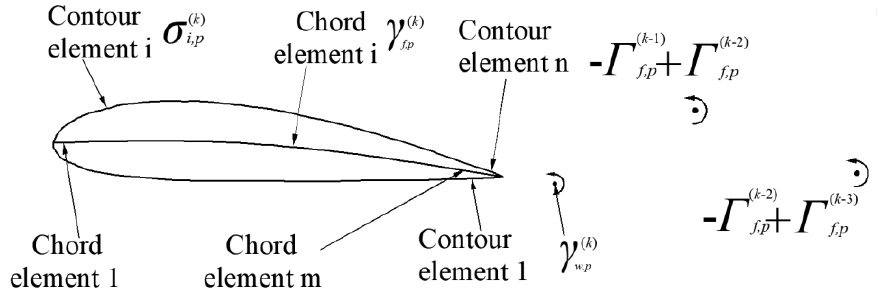
Figure 3. The schematic diagram of the finite vortex method. Subscript i is the serial number of source and sink singularities, p is the number of blades, f represents the attached vortex on the blade, w represents the shedding vortex in the wake, superscript k is the time step.